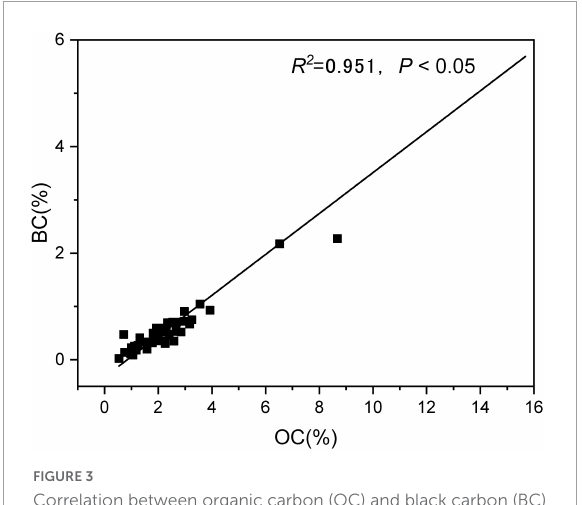
FIGURE3 Correlation between organic carbon (OC) and black carbon (BC) content of sediments from different mangrove wetlands in China. R 2 and P indicate the fitness and significance of the linear regression models,